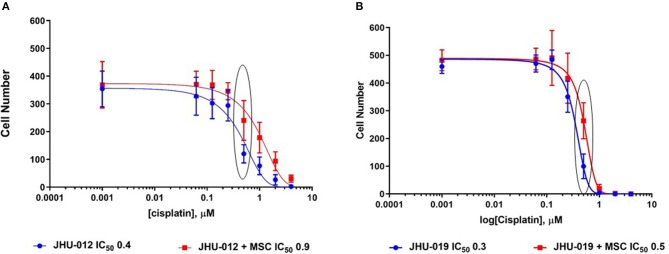
MSCs mediate decreased cytotoxicity to cisplatin in OSCC. Using a clonogenic assay approach, cisplatin dose response curves were generated for clones derived from JHU-012 and −019 cells grown alone and in 1:1 co-culture with MSCs. There was a significant increase in the cisplatin dose response curve and IC50 in clones derived from co-culture with MSCs for JHU-012 (A) and −019 (B; n > 3; p < 0.001).